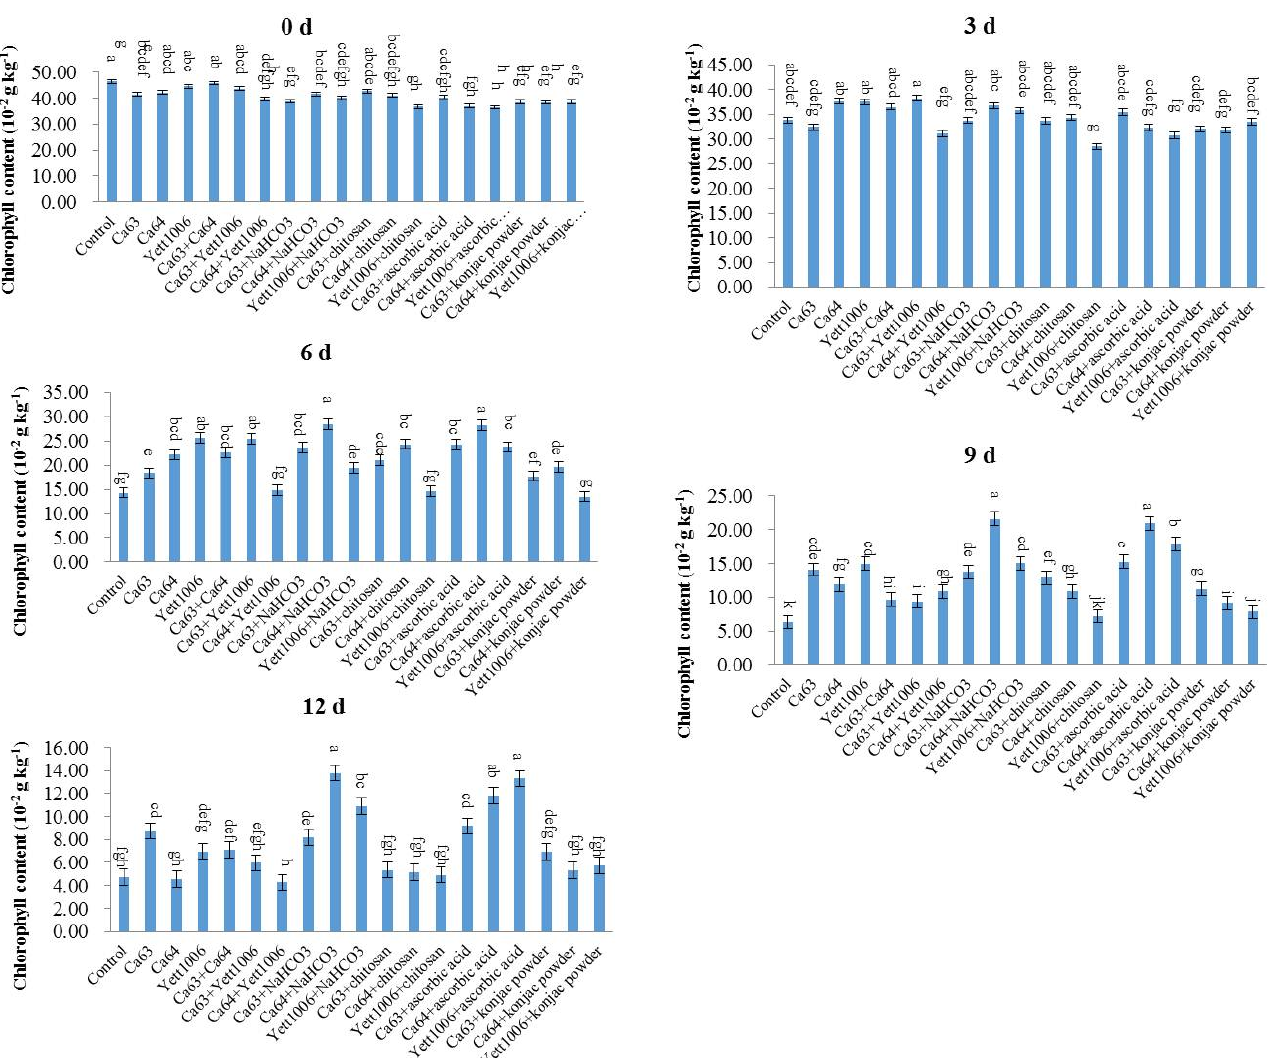
Figure 7. Evaluation of chlorophyll content in snap beans between different treatments. Error bars represent the standard deviations of means ( n = 3). On the bars, the small letters indicate a significant difference in the treatment according to Duncan’s multiple difference test ( p < 0.05).